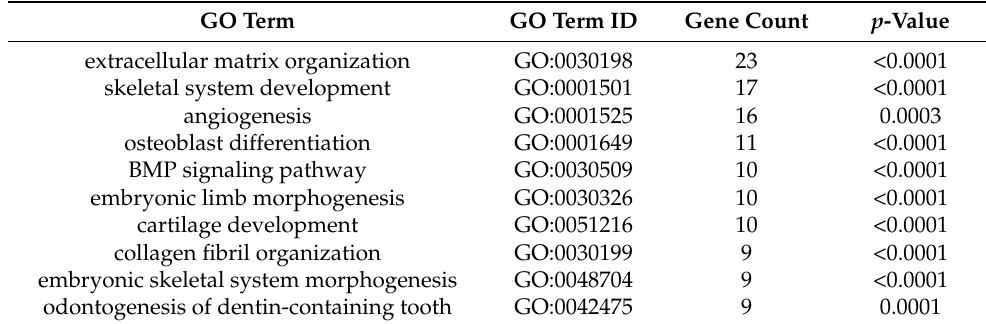
Table 1. Functional annotations for the differentially expressed genes using GO terms.